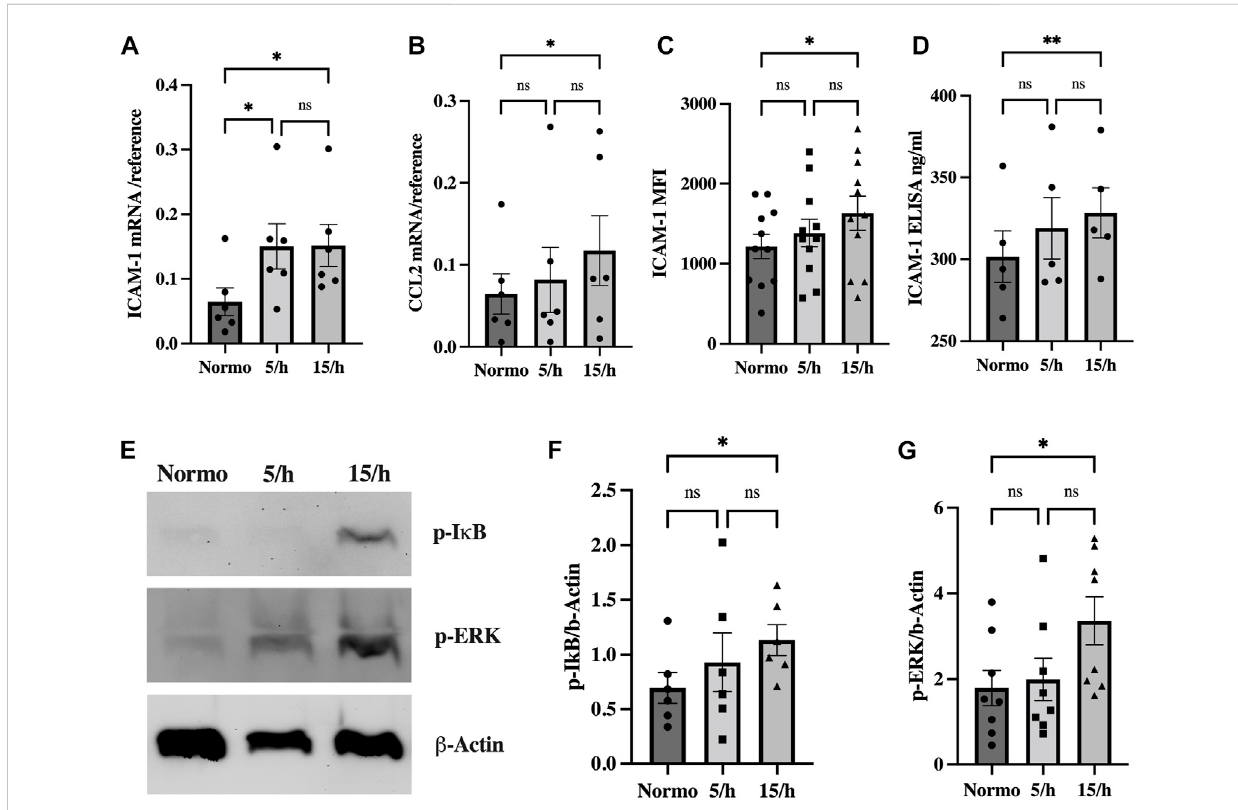
Intermittenthypoxia inducesin fl ammatorysignaling drivenby NF- κ B andERK activation toupregulate theadhesion and signaling molecule ICAM-1 andthechemokineCCL2.Wedetectedan increased mRNA expression oftheadhesion molecule ICAM-1 (A) and thechemokineCCL2 (B) inqRT-PCRin the group with 15 hypoxic events per hour compared to the normoxic control. Accordingly, ICAM-1 surface expression detected in fl ow cytometry (C) and cleaved ICAM-1 concentration in the cell culture media measured by ELISA (D) were signi fi cantly increased. Western blot analysis showed signi fi cantly elevatedp-IkB and p-ERK (E) expressionas surrogate for NF- κ Band ERK activation already in the5/hgroup, fi nally reaching signi fi cant levels in the group with 15 cycles per hour (F, G) . Shown are means ± SEM. N = 6 – 10, * p = 0.05, ** p =